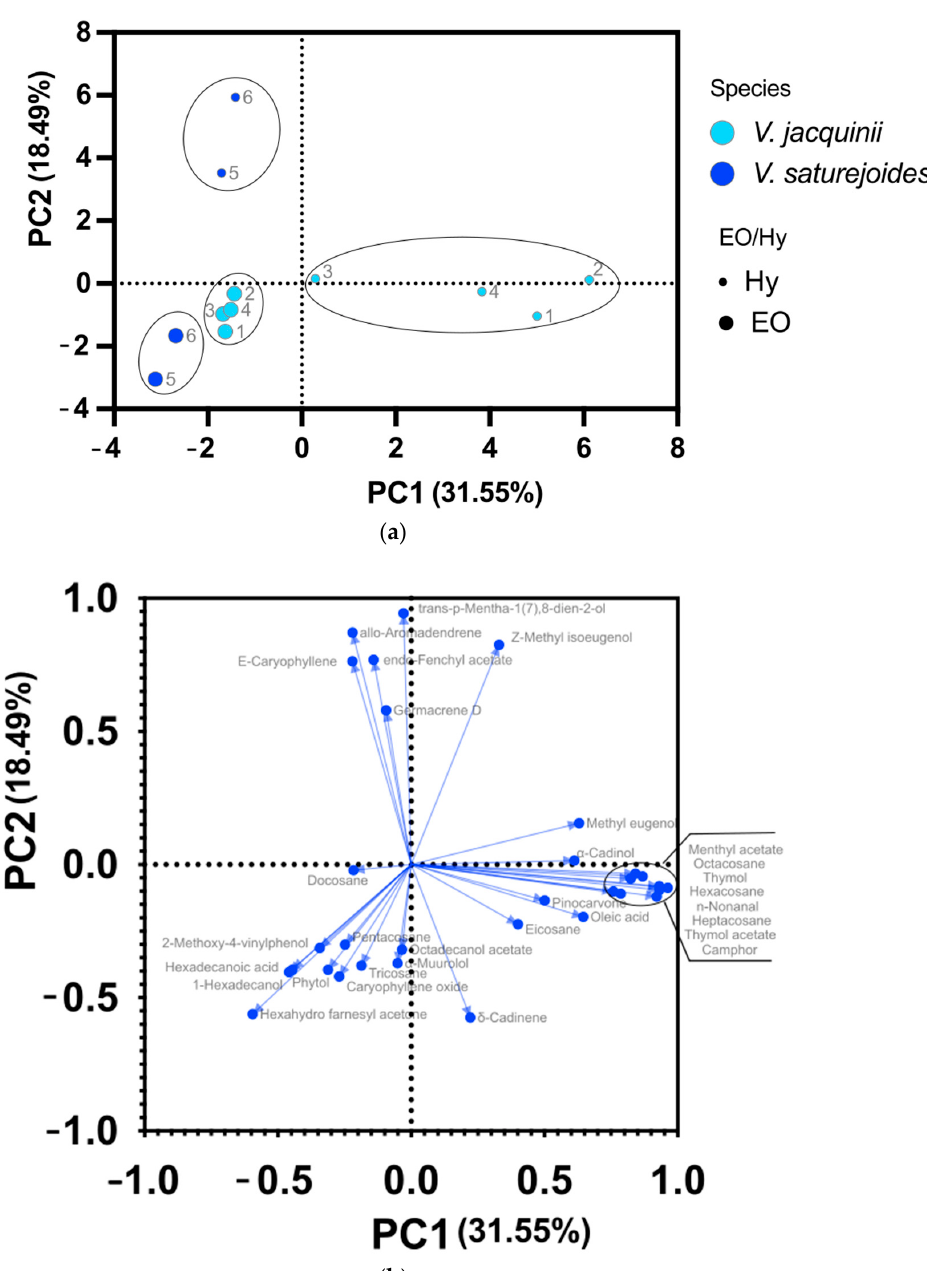
Figure 3. PCA analyses of volatile compound in the amount larger than 2% from essential oils (EO) and hydrosols (Hy) of V. austriaca ssp. jacquinii from four locations. ( a ) PCA score plot allocating different species into clusters; ( b ) PCA loading plots of volatiles from the first and second principal component.